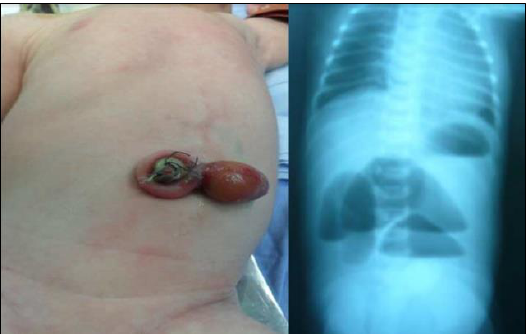
Figure 1: Extra-abdominal bowel remnant and x-ray showing small bowel